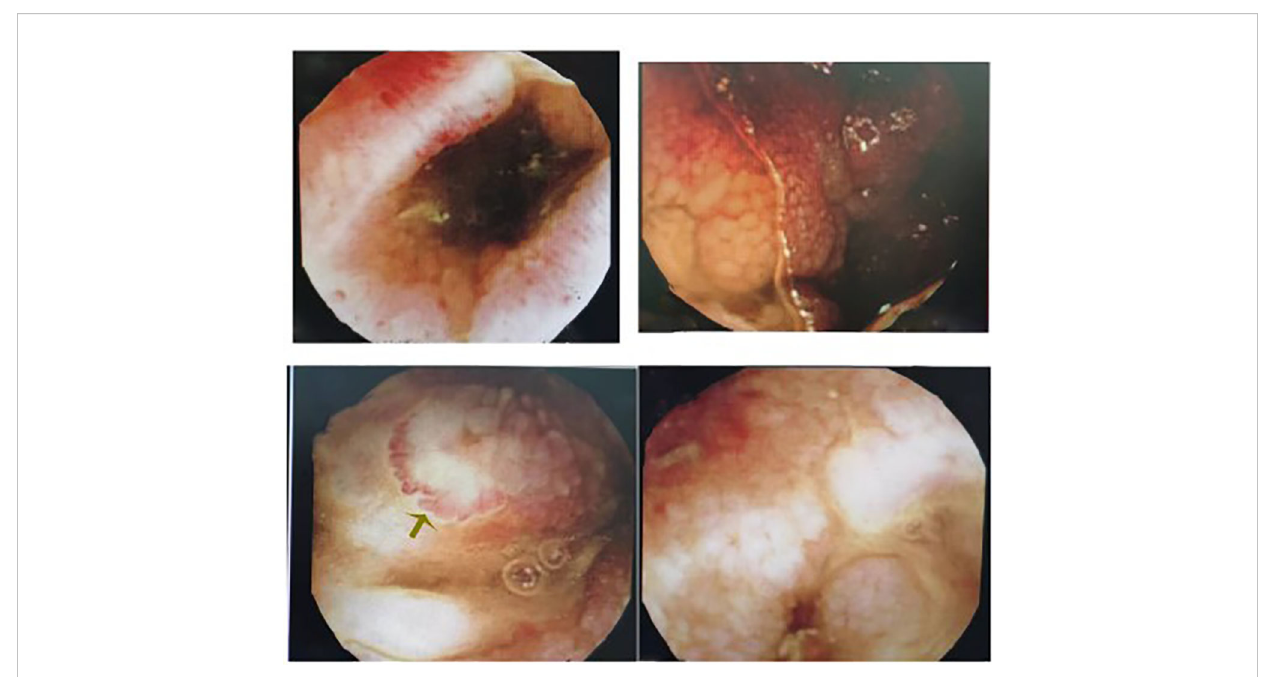
FIGURE 3 Capsule endoscope: The small intestinal mucosa has multiple fl aky erosions and pitting lesions, with hyperemia and edema surrounding them.